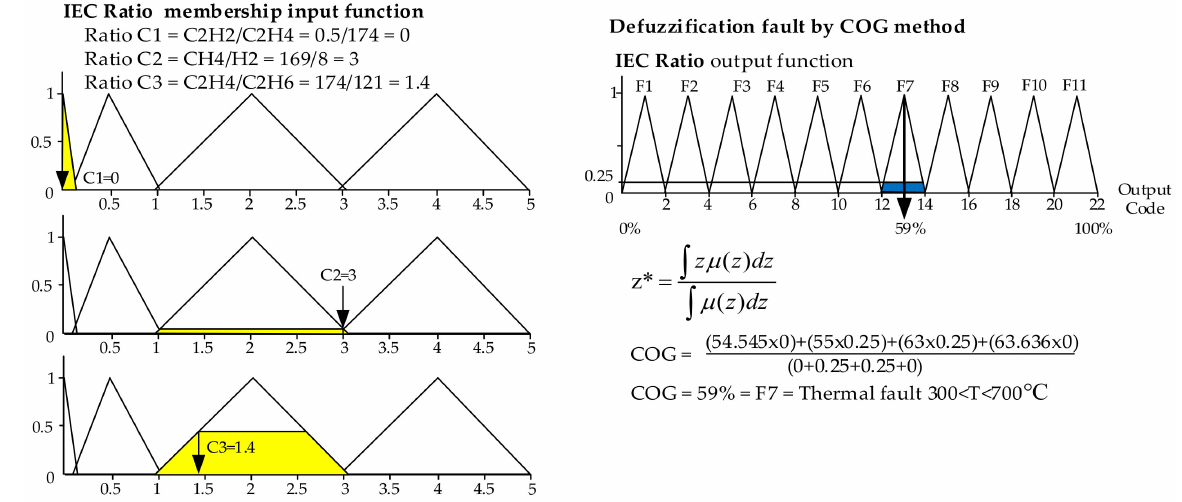
Figure 5. Triangular membership function fuzzification and defuzzification for the IEC ratio method.